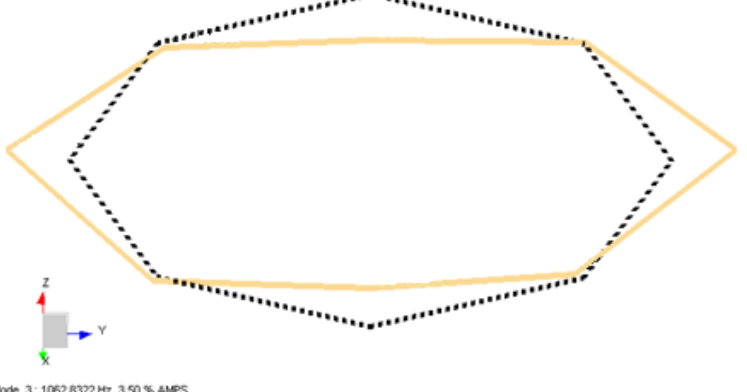
Figure 15. Second mode shape obtained from LMS Test Lab software for the Type-2 coil sample.